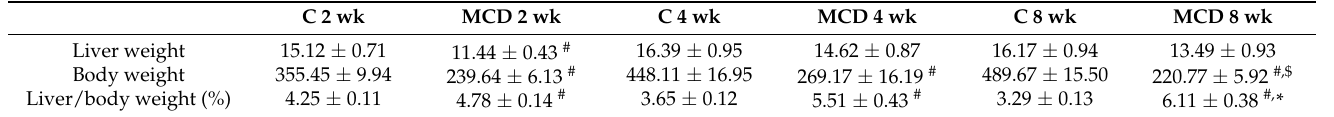
Table 1. Effects of MCD diet on rat liver weight, body weight and liver/body weight ratio.